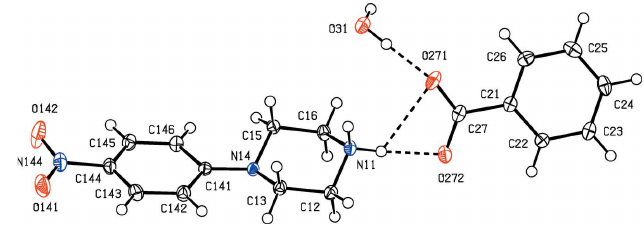
Figure 2 The molecular structure of (II), showing hydrogen bonds (drawn as dashed lines) within the selected asymmetric unit. Displacement ellipsoids are drawn at the 50% probability level.